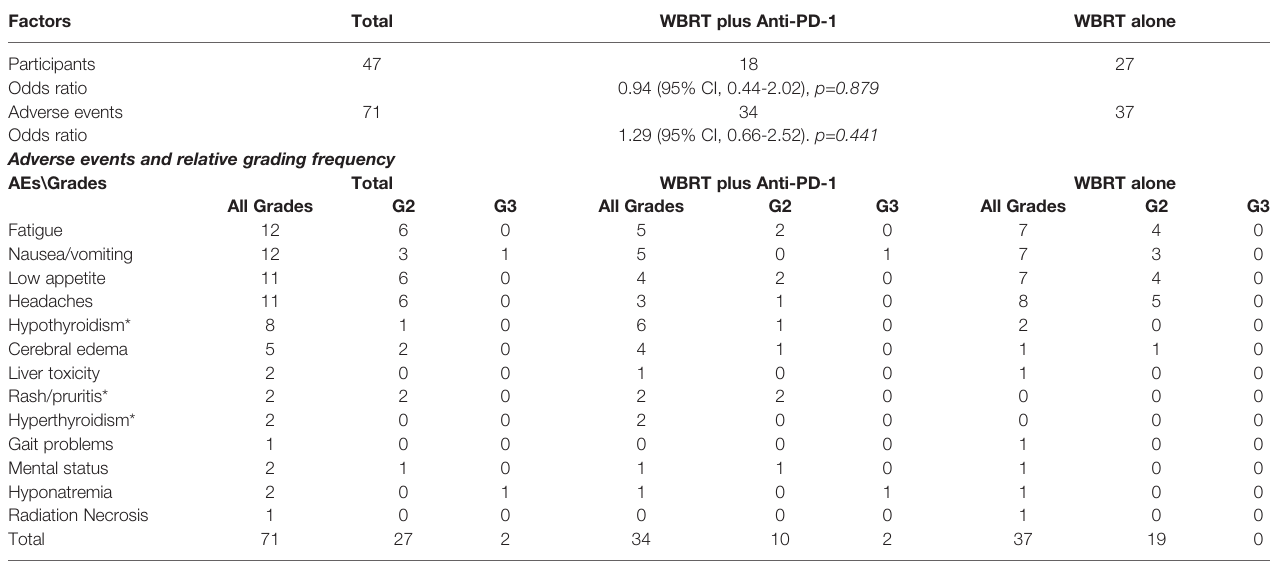
TABLE 4 | Adverse events experienced by two